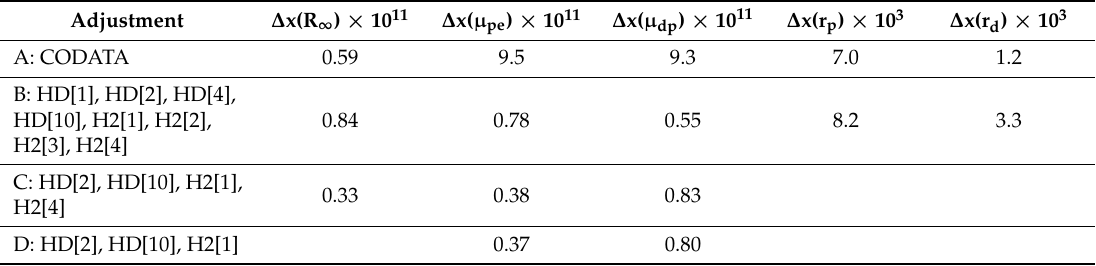
Table 5. Estimation of the accuracy of the determination of fundamental constants from an adjustment of two-photon transitions of hydrogen molecular ions, that are referenced in Table 4. Line A gives the uncertainties of relevant fundamental constants from the CODATA 2014 adjustment. Lines B, C, and D give the uncertainties for the determination of the fundamental constants with the adjustments discussed in the